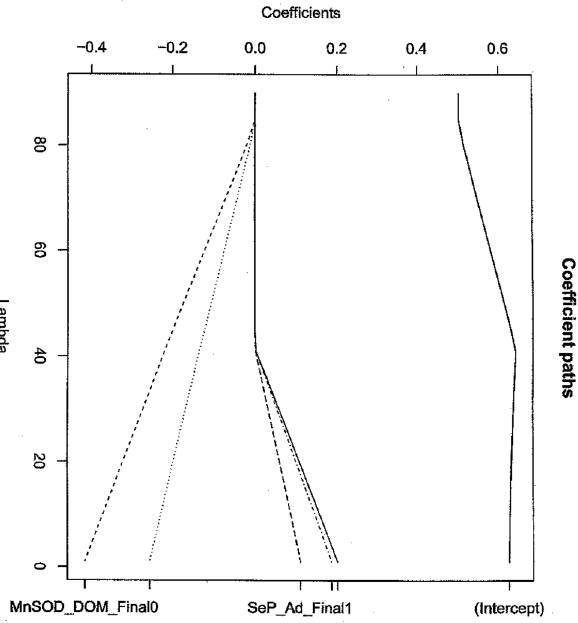
Figure 1. The Group Lasso Coefficient plot for the logistic regression. Containing MnSOD_DOM_FINAL and SeP_Ad_Final. We note that for lambda = λopt none of the paths shrink to zero suggesting that a SNP-SNP interaction, as reported in 19